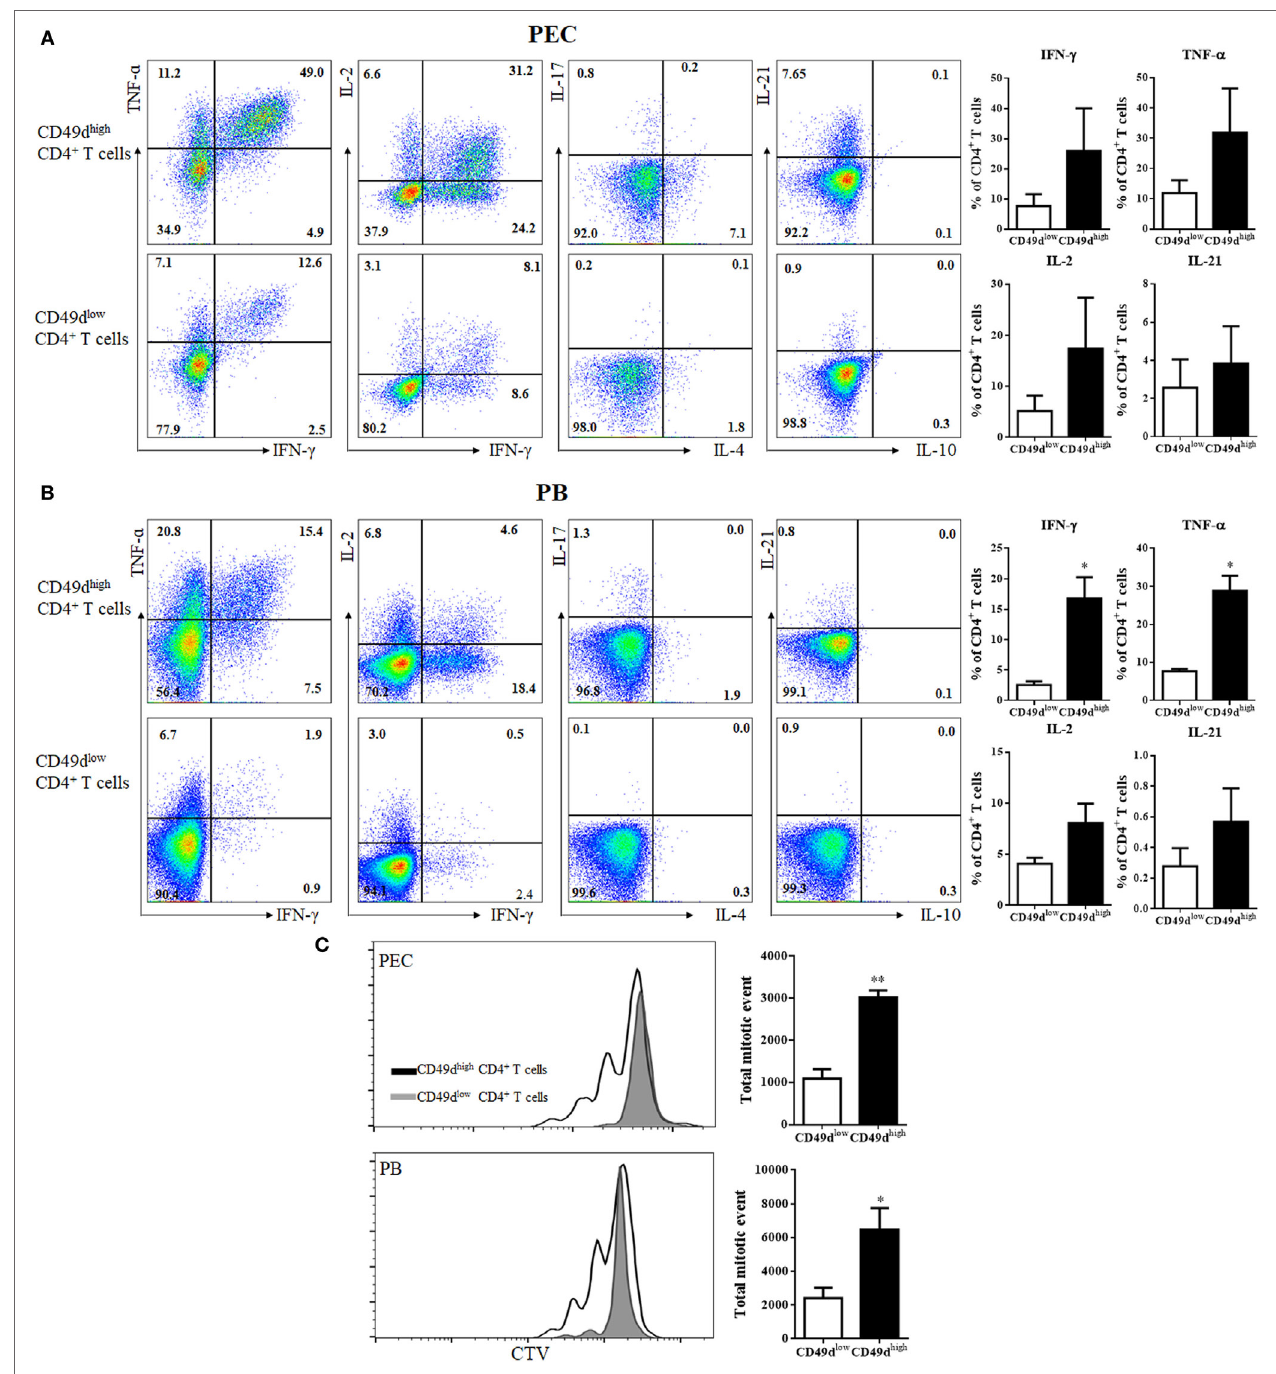
FigUre 3 | CD49d high CD4 + T cells rapidly secreted Th1 cytokines. (a,B) Representative flow cytometric plots of intracellular staining for various cytokines (TNF- α , IFN- γ , IL-2, IL-4, IL-10, IL-17, and IL-21). (a) Isolated peritoneal cells and (B) PB mononuclear cells were stimulated with PMA and ionomycin for 4 h. Cytokine expression in CD49d high CD4 + and CD49d low CD4 + T cells was analyzed by flow cytometry. Data are representative of three independent experiments (left panel). Proportions of TNF- α , IFN- γ , IL-2, and IL-21 positive CD4 + T cells in CD49d high CD4 + (black) and CD49d low CD4 + T cells (white) in the (a) PEC and (B) blood (right panel). (c) CD49d high CD4 + and CD49d low CD4 + T cells isolated from the PEC or PB were sorted and labeled with CTV, then stimulated for 72 h with immobilized anti-CD3 and anti-CD28 antibodies. The proliferation of CD49d high CD4 + T cells (solid lines) and CD49d low CD4 + T cells (gray filled) is shown, along with total mitotic events in CD49d high CD4 + (black) and CD49d low CD4 + T cells (white). Data are expressed as the mean ± SEM ( n = 3 donors per each group). * P < 0.05, ** P < 0.01; Student’s t -test. Abbreviations: TNF- α , tumor necrosis factor- α ; IFN- γ , interferon- γ ; IL-2, interleukin-2; IL-4, interleukin-4; IL-10, interleukin-10; IL-17, interleukin-17; IL-21, interleukin-21; PMA, phorbol myristate acetate; PEC, peritoneal cavity; PB, peripheral blood.